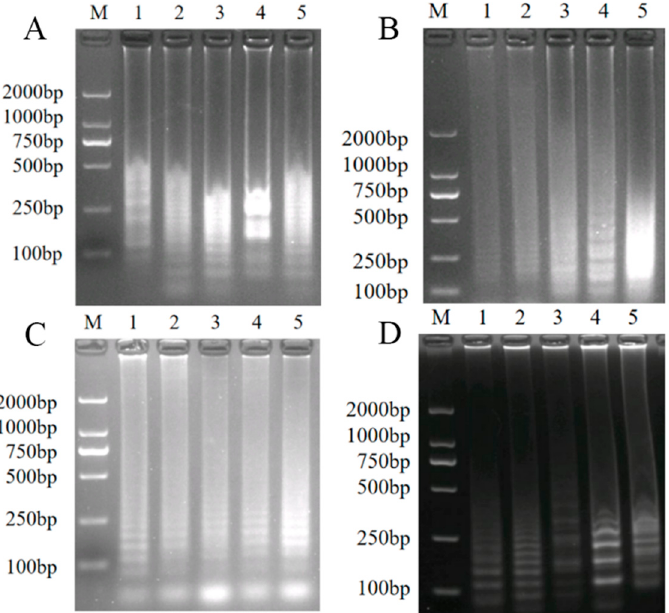
Figure 7. Optimization of LAMP reaction conditions. ( A ) Optimization of the LAMP assay’s dNTP concentrations for the detection of A. phaeospermum . M: DL 2000 DNA marker; 1–5: dNTP concentrations of 0.9, 1.0, 1.1, 1.2, and 1.3 mM, respectively. ( B ) Optimization of the LAMP assay’s Mg 2+ concentrations for the detection of A. phaeospermum . M: DL 2000 DNA marker; 1–5: Mg 2+ concentrations of 1.5, 1.8, 2.1, 2.4, and 2.7 mM, respectively. ( C ) Optimization of the LAMP assay’s betaine concentrations for the detection of A. phaeospermum . M: DL 2000 DNA marker; 1–5: betaine concentrations of 0.5, 0.6, 0.7, 0.8, and 0.9 mM, respectively. ( D ) Optimization of the LAMP assay’s primer concentration ratio for the detection of A. phaeospermum . M: DL 2000 DNA marker; 1–5: the external primer concentration was fixed at 0.1 μ M, while the internal primer concentrations were 0.2, 0.4, 0.8, 1.6, and 3.2 μ M, respectively.